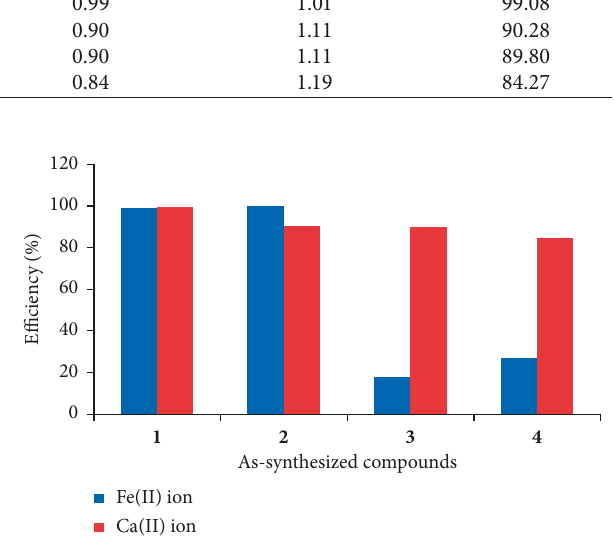
Figure 4: Results for the removal of Fe 2+ and Ca 2+ ions by compounds 1–4 .